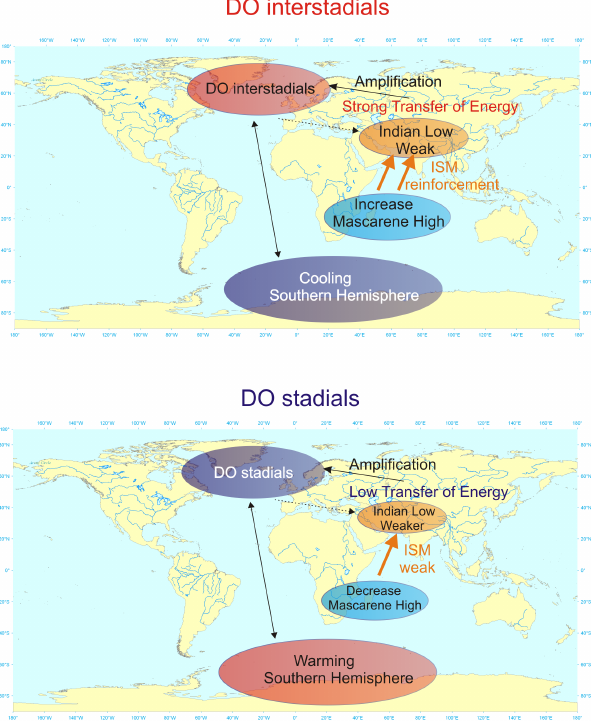
Fig. 8. A conceptual scheme showing how the Indo-Asian monsoon can play an active role to amplify inter-hemispheric energy transfer for suborbital changes during the last glacial